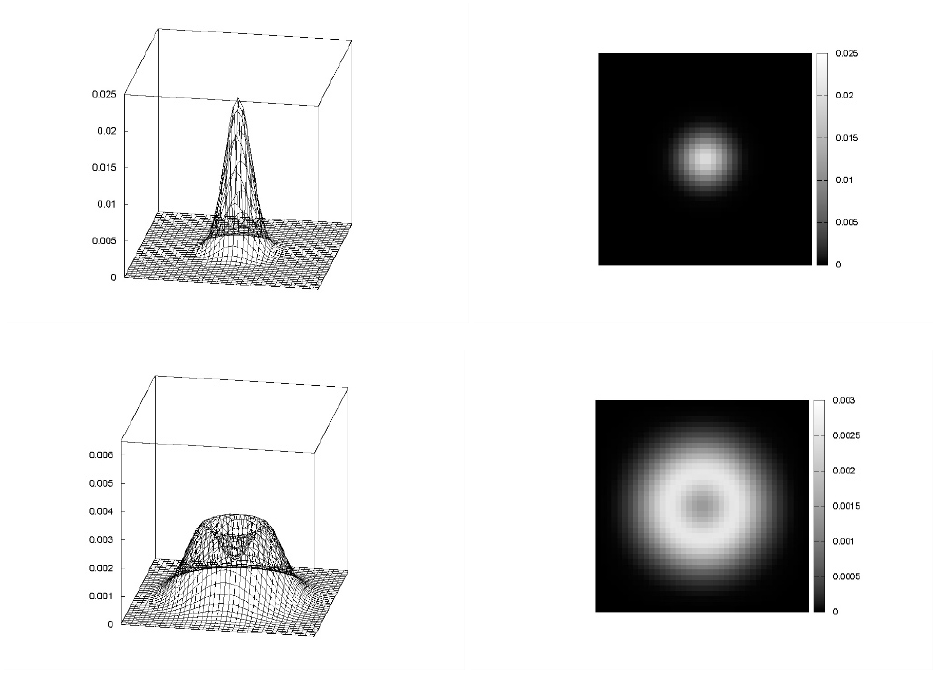
Figure 3. The interaction strength is κ = 0 . 5 .